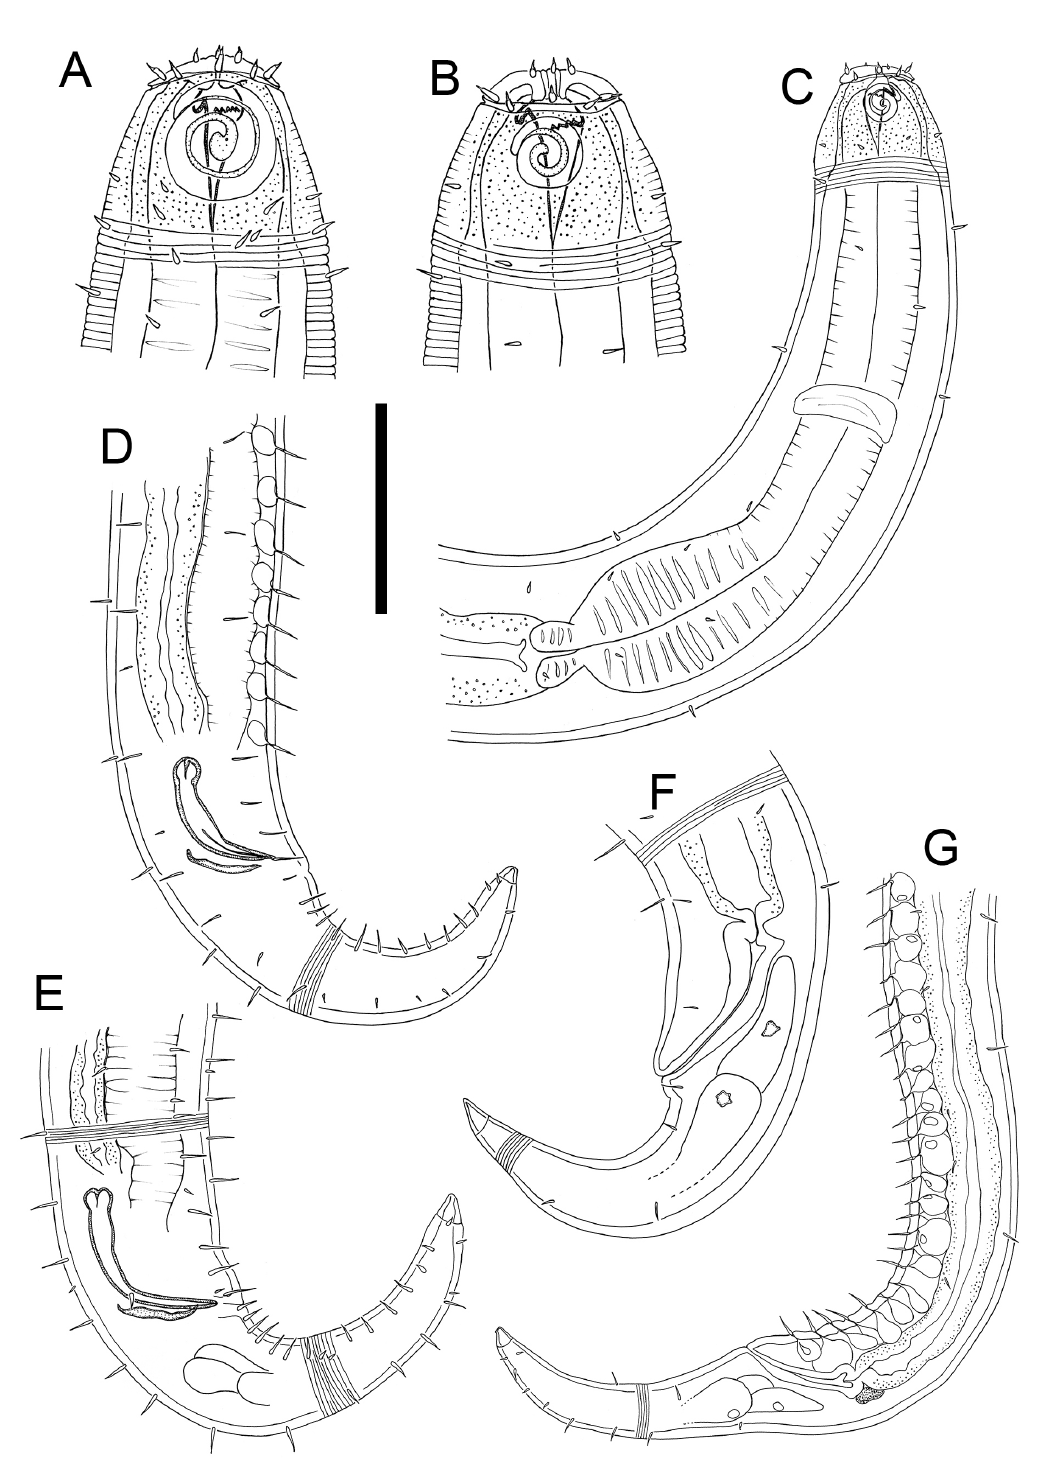
Fig. 16. Desmodora parapilosa sp. nov. A , E . Holotype (NIWA154921). B – C , F – G . Paratype (NIWA 154923). D . Paratype (NIWA154922). A . Male cephalic region. B . Female cephalic region. C . Female anterior body region. D – E . Male posterior body region. F – G . Female posterior body region. Scale bar: A = 50 µm; B = 40 µm; C = 75 µm; D–E = 70 µm; F = 60 µm; G = 100